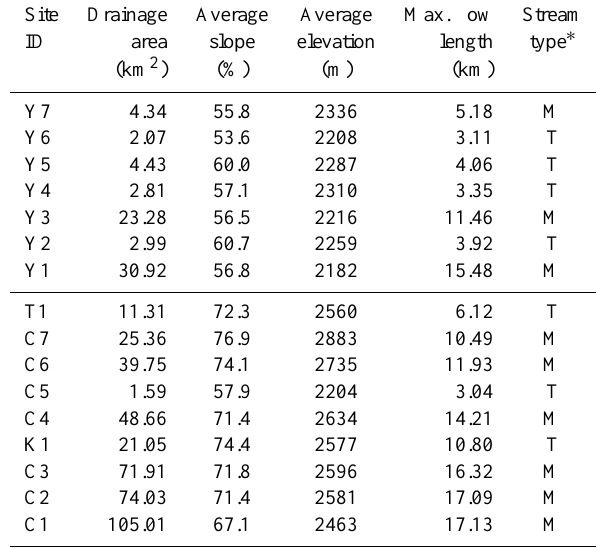
Table 1. The basic landscape characteristics of the 16 sampling